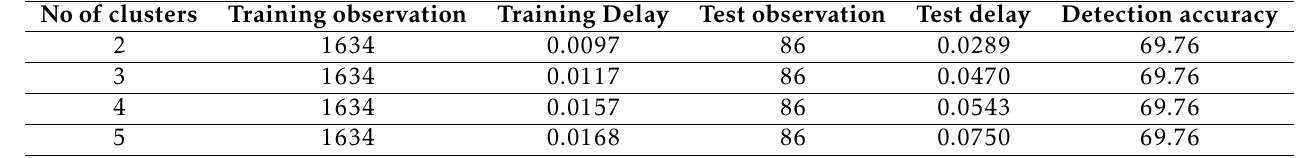
Table 1. Performance Summary of k-means clustering based CSS scheme using Euclidean Distance metric